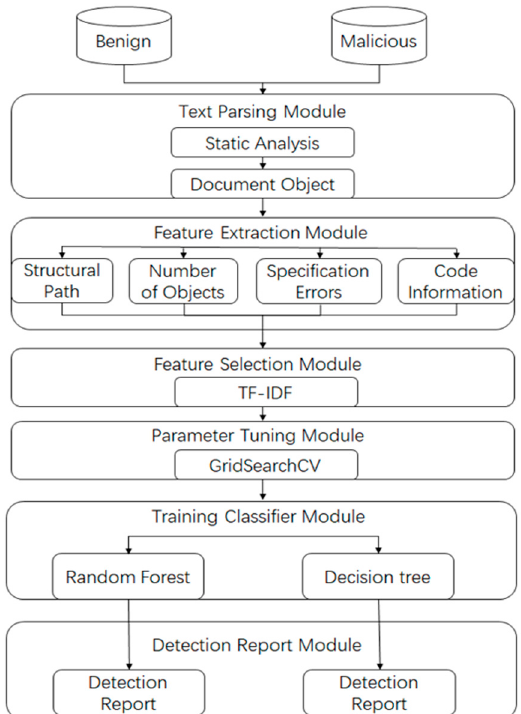
Figure 3. The framework of the proposed malicious document static detection system.